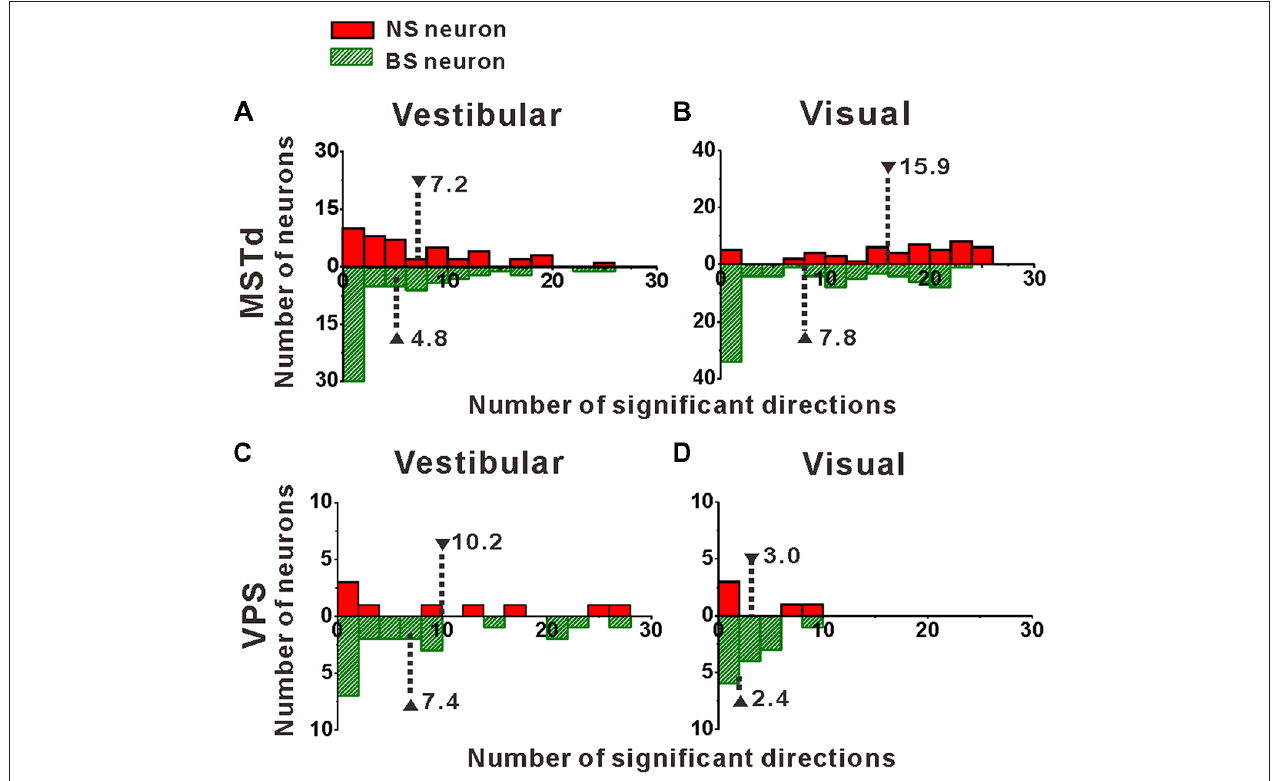
FIGURE 4 | Distribution of the number of significant directions. (A,B) Distribution histogram of the number of neurons that have a significant response to vestibular (A) and visual stimuli (B) for NS and BS neurons in MSTd. A total of 45 NS neurons and 61 BS neurons with significant directional tune to vestibular stimuli were selected (both p < 0.05, ANOVA test) and a total of 52 NS neurons and 83 BS neurons with significant directional tune to visual stimuli were selected (both p < 0.05, ANOVA test). (C,D) Distribution histogram of the number of neurons that have a significant response to vestibular (C) and visual stimuli (D) for NS and BS neurons in VPS. The neurons analyzed in the graph have a significant directional tune to vestibular or visual stimuli (both p < 0.05, ANOVA test). Vestibular tuning: NS neuron ( N = 13), BS neuron ( N = 7). Visual tuning: NS neuron ( N = 22), BS ( N = 19). Note that the number of significant direction distributions for BS neurons were plotted as downward projecting histograms simply for illustrative